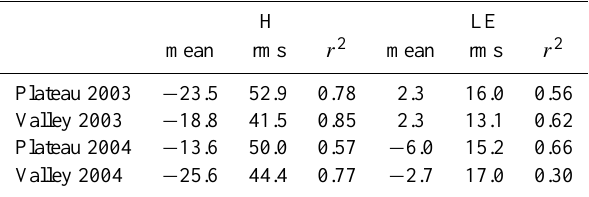
Table 1. Mean and rms errors (Wm − 2 ) and r 2 for all simulations of sensible and latent heat